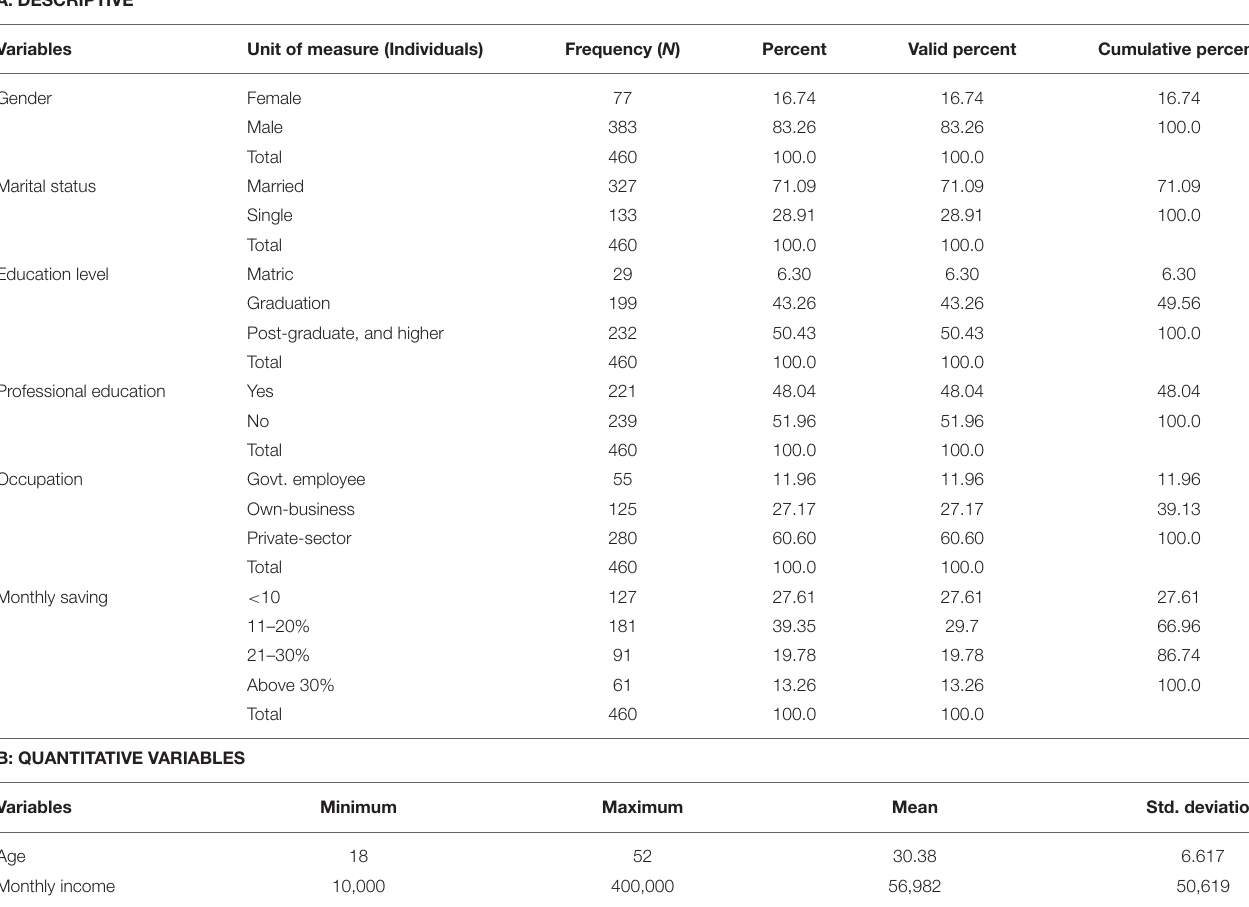
TABLE 2 | Demographic and socio-economic characteristics of